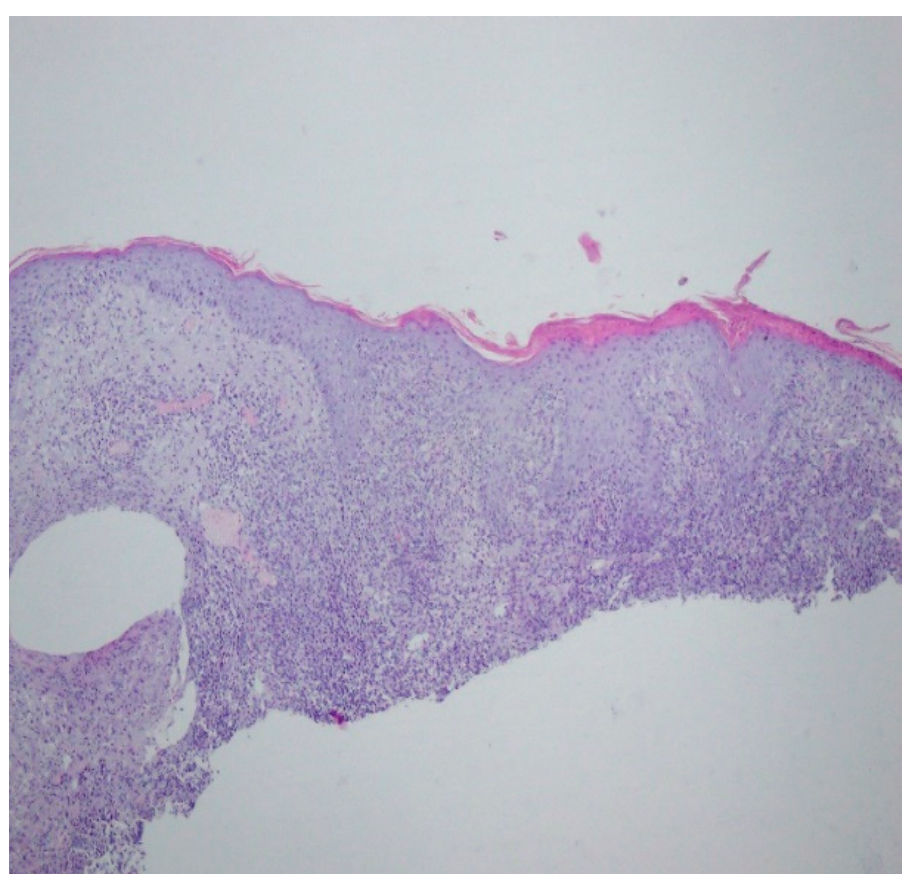
Figure 11. Thickened epidermis. Lymphocytic and histiocytic inflammatory infiltration with multiple plasmacytes. Histopathological picture and data from the history are consistent with syphilis. Based on the clinical picture, numerous laboratory and imaging examinations, as well as consultations, tertiary syphilis was diagnosed in the skin, central nervous system, eyes and bones. During hospitalisation, crystalline penicillin (4 × 5 million units i.v.) was ad- ministered for 14 days, which improved the inflammatory parameters, the dermatological lesion in the right clavicle and the lesions on the scalp, as well as reducing the pain in the joints. On the last day of hospitalisation, the patient was given 2.4 million units of benzathine benzylpenicillin i.m. In the first days of treatment with crystalline penicillin, the patient also received methylprednisolone (24 mg p.o.) in order to avoid Jarisch Herxheimer reaction. The patient remains under the care of Dermatological, Orthopaedic, Neurology and Ophthalmology Outpatient Clinics. During the outpatient follow-up in May 2022, a total resolution of the skin lesions on the scalp and healing of the ulceration in the right clavicle leaving a mosaic scar were noted (Figures 12 and 13). A slightly reduced tumour in the shaft of the right clavicle was observed (Figure 14). Serum examinations conducted in September 2022 showed RPR reaction at the titre of